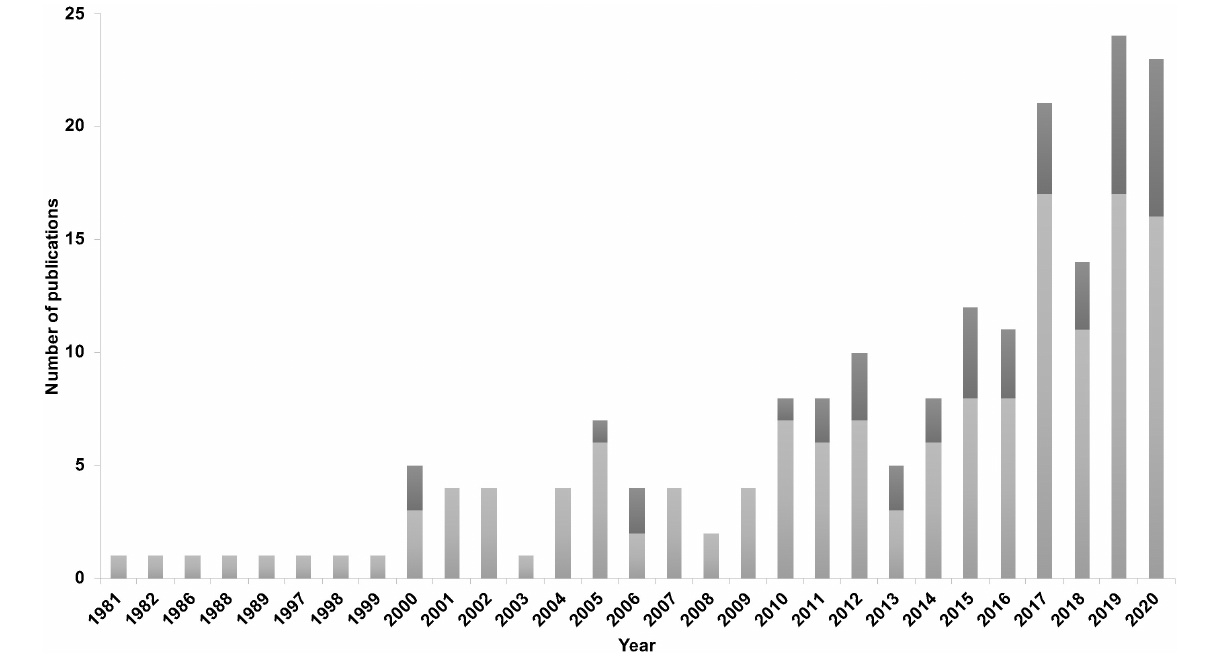
Frontiers in Marine Science |